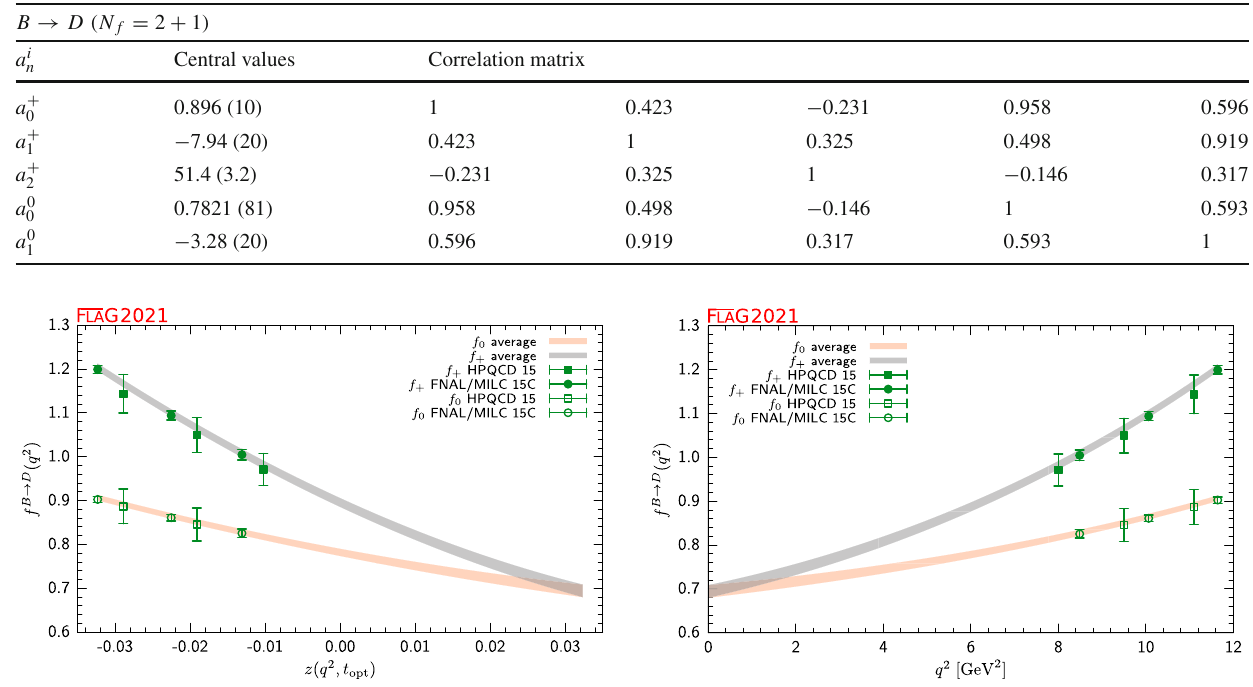
Fig. 34 The form factors f + ( q 2 ) and f 0 ( q 2 ) for B → D (cid:6)ν plotted versus z (left panel) and q 2 (right panel). See text for a discussion of the data sets. The grey and salmon bands display our preferred N + = N 0 = 3 BCL fit (five